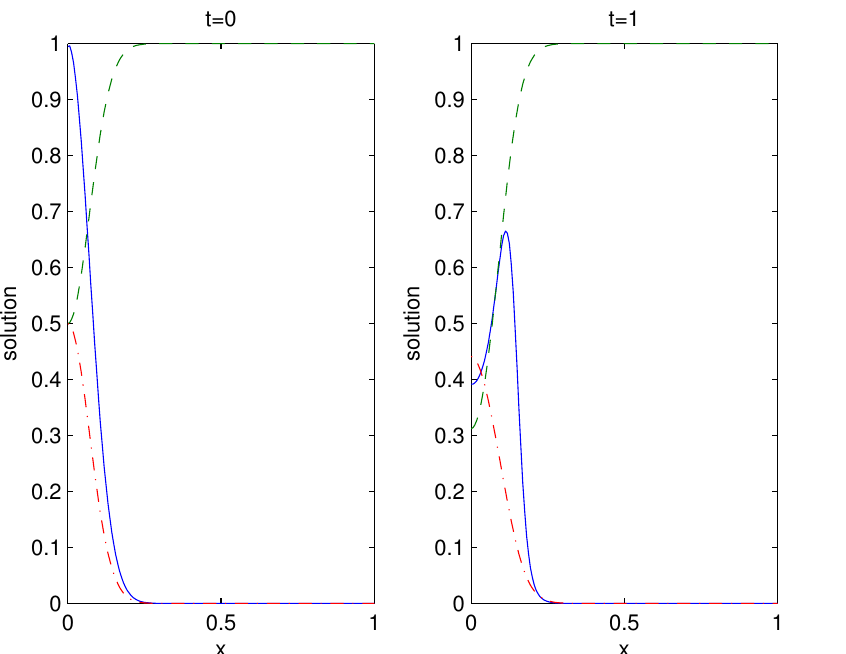
Figure 4. The solid line represents the density of cancer cells, the dashed line denotes the density of the ECM, and the dashed and dotted line denotes the concentration of the MDE at time t = 0 and t = 1. Solutions with the parameter value d n = 0.0002, Example 5.